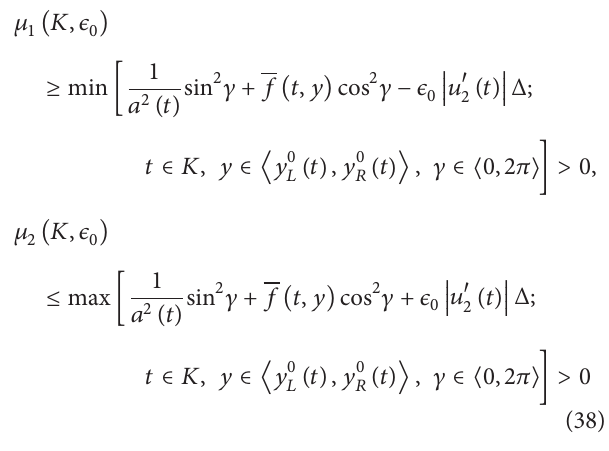
As it follows from the shape of potential 𝑉 and the phase , 𝑦 𝜖 (𝑡 ∗ ) → ∞ for 𝜖 → 0 + and 𝑡 ∗ ∈ portrait for 𝑡 > 𝑡 SC 2 , 𝑡 ⟩ (𝑡 𝐸 SC 2